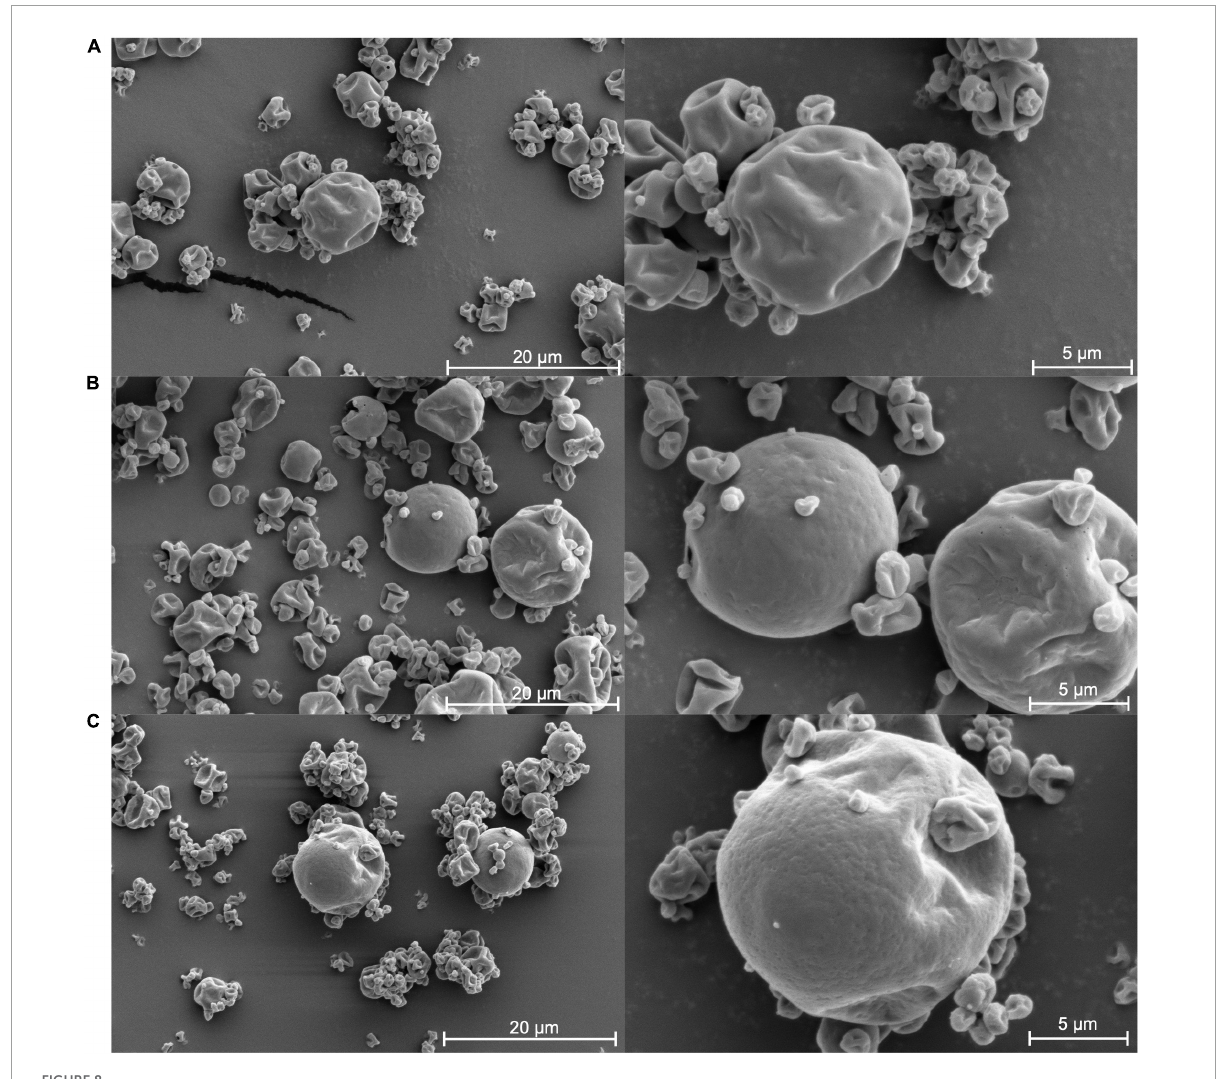
FIGURE8 The SEM of microcapsules: CoCo (A) , low-EC CoCo (B) and high-EC CoCo (C)